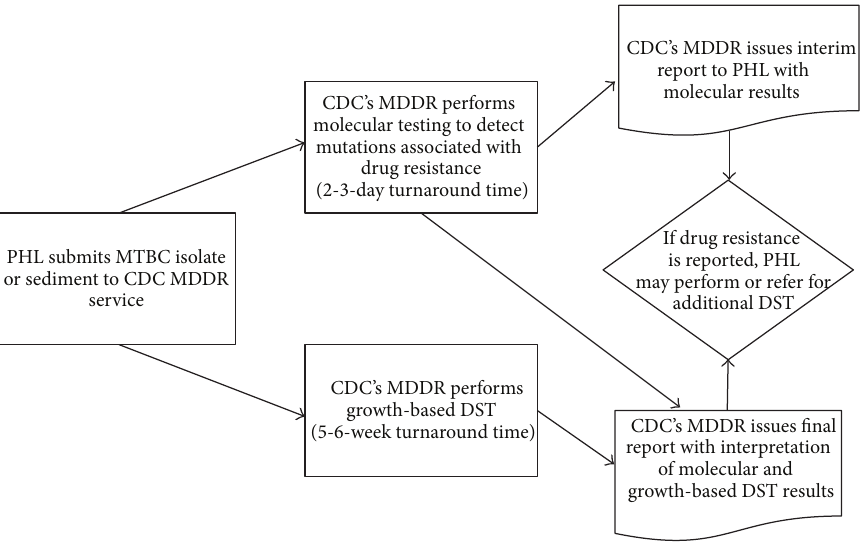
Figure 1: Workflow for MTBC isolates and sediments submitted by PHL to the CDC MDDR service for detection or confirmation of drug resistance. MTBC = Mycobacterium tuberculosis complex. PHL = Public Health Laboratory. CDC = Centers for Disease Control and Prevention. MDDR = molecular detection of drug resistance. DST = drug susceptibility testing.